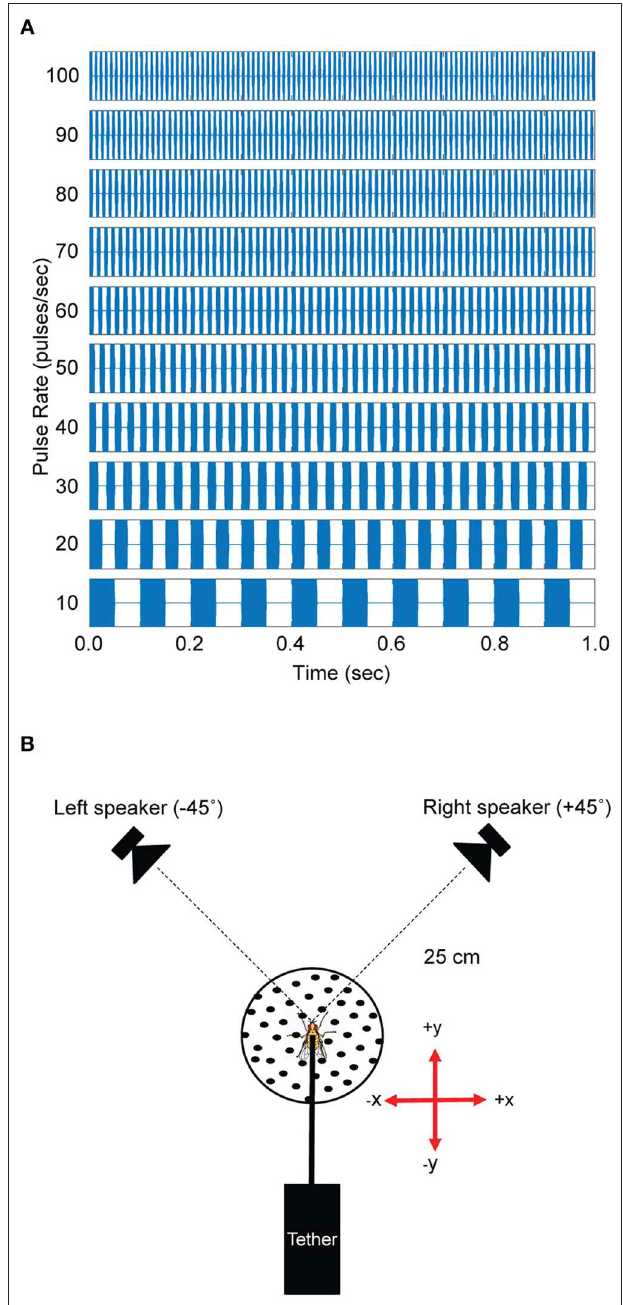
FIGURE 1 | Acoustic stimuli and experimental arrangement. (A) Acoustic stimuli used in phonotaxis experiments were 1s in duration. Test songs varied in pulse rates by changing the pulse duration and interval between pulses in equal amounts to achieve a 50% duty cycle. The 50 pulses/s and 70 pulses/s songs were used as the standard (reference) song in testing responses from Floridian and Californian Ormia ochracea , respectively. (B) Flies were tethered and held on top of the spherical treadmill system at a fixed position 25cm away from the left and right speakers. Left and right speakers were positioned at − 45 ◦ and + 45 ◦ relative to the midline axis of the fly. Rotations of the treadmill in the forward direction is registered as positive y values while rotations to the right is registered as positive x values and these values can be used to reconstruct virtual walking